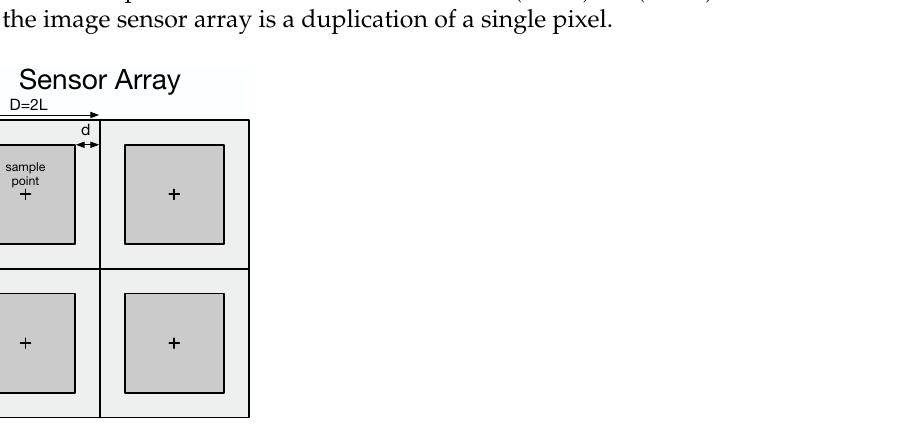
Figure 1. Geometric model for the sensor unit array. The grey area is the photon-sensitive area of the pixel. The cross points mark the centers of the